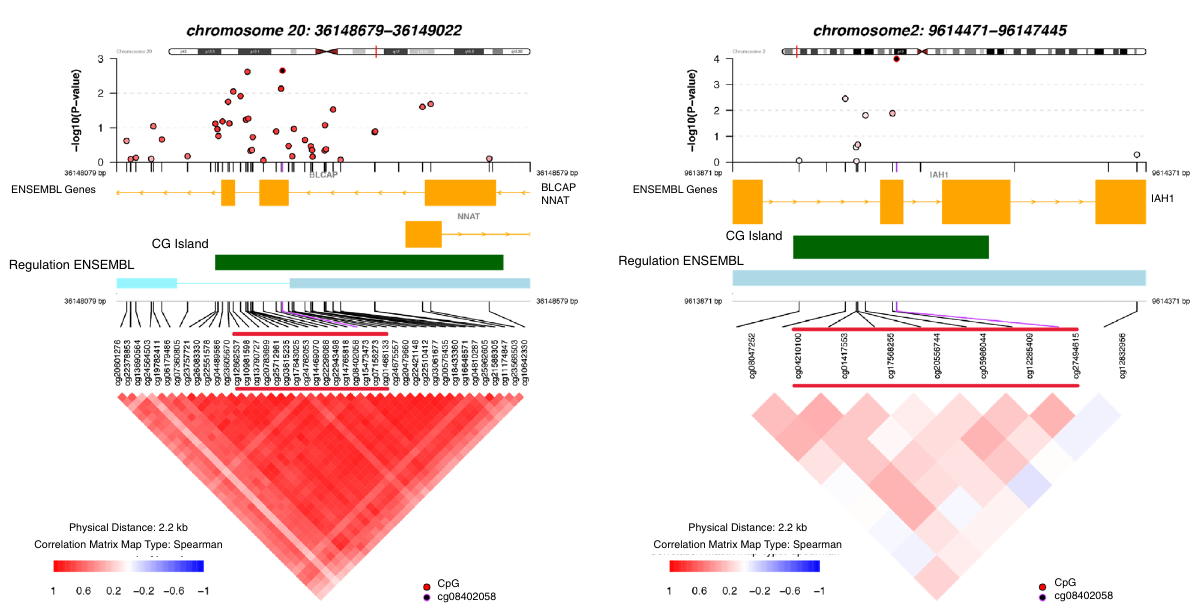
Figure 2. Differentially methylated regions associated with left-handedness in meta-analysis. The figure represents the differentially methylated regions at P -adjusted < 0.05 in meta-analysis of DMR statistics across groups of NTR adults and ALSPAC adults ( N = 3712). The top panel of each plot depicts the EWAS P -values for CpGs in the differentially methylated regions ( A ) at chromosome 20; and ( B ) at chromosome 2. The x-axis indicates the position in base pair (bp) for the region, while y-axis indicates the strength of association from meta-analysis EWAS with left-handedness (adjusted model). The middle panel shows the genomic coordinates (genome build GRCh37/hg19) and the functional annotation of the region: the ENSEMBL Genes track shows the genes in the genomic region (orange); the CpG Island track shows the location of CpG islands (green); the Regulation ENSEMBL track shows regulatory regions (blue). CpGs from DMR associated with left-handedness are indicated with red lines above the correlation heatmap. More detailed information on the regions is provided in Table 4. The bottom panel shows the Spearman correlation between methylation levels of CpGs in the window. The figure was computed using the R package coMET. See additional information on CpGs from the regions in Supplementary Table